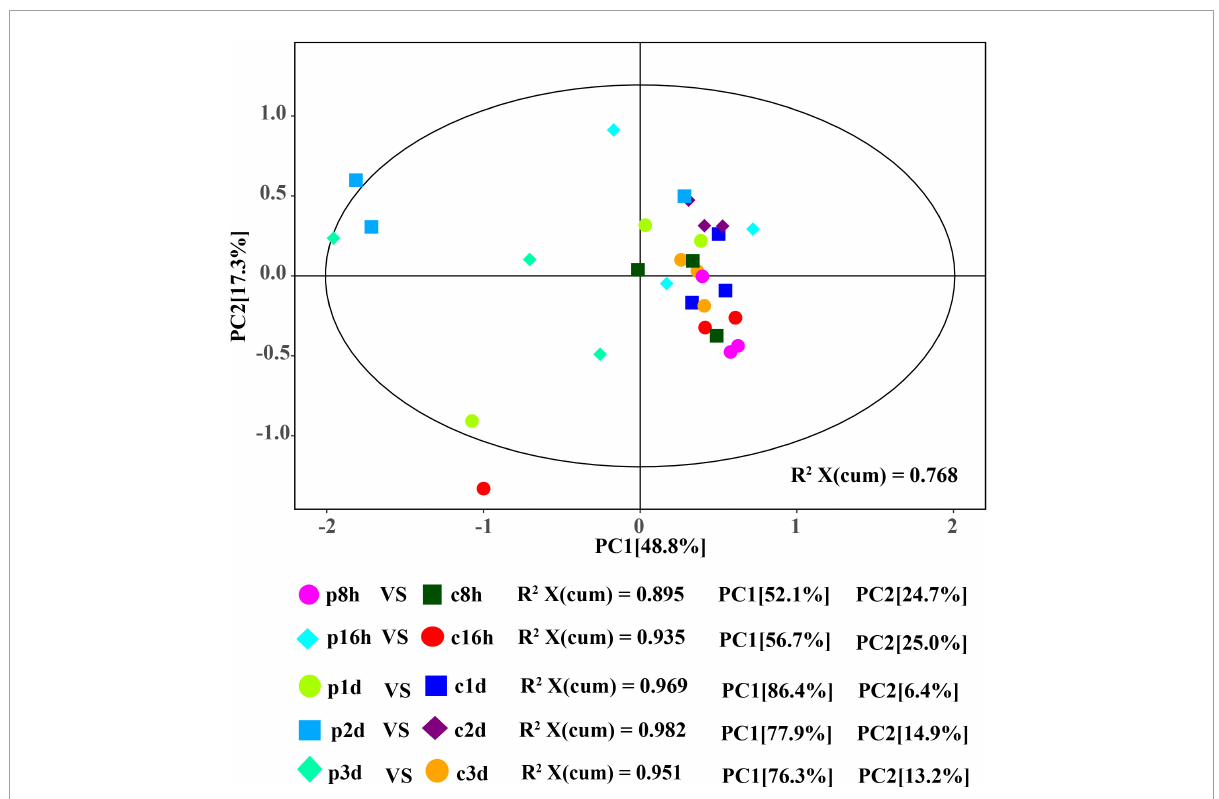
FIGURE1 Score plot of the PCA models applied to parasitized and control aphids. p8h, p16h, p1d, p2d, and p3d indicate parasitized cotton aphids for 8, 16 h, 1, 2, and 3 days, respectively. Similarly, c8h, c16h, c1d, c2d, and c3d represent the above-treated control groups, respectively.